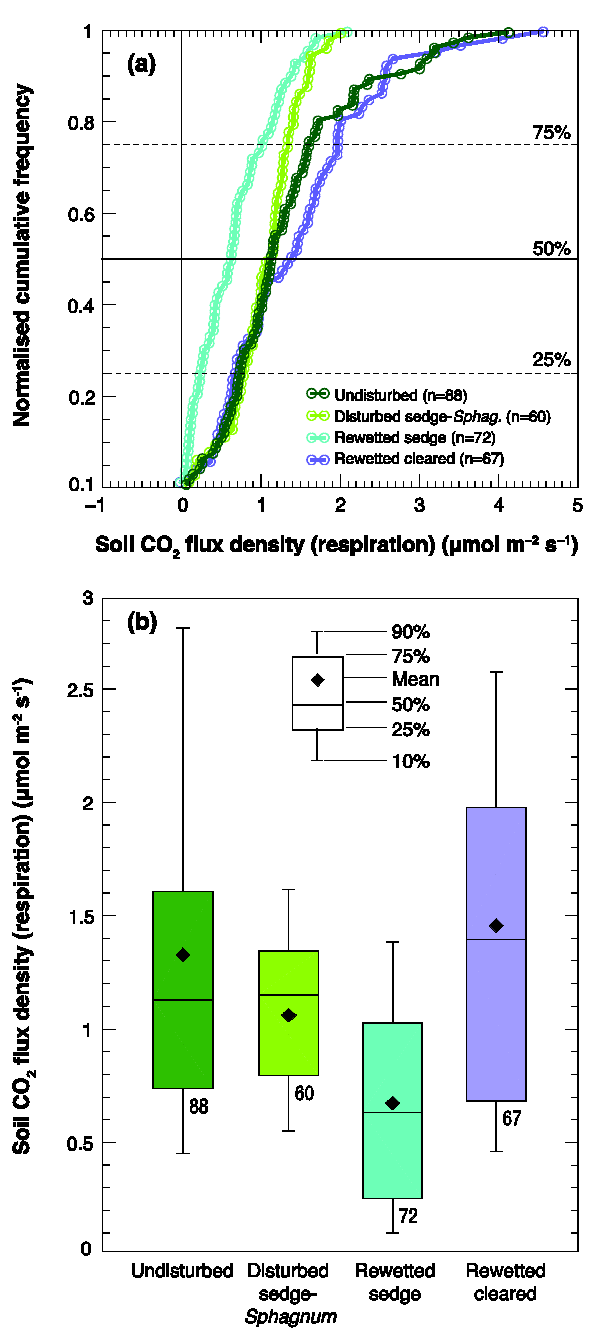
Figure 3. (a) Cumulative frequency distributions of all individual soil carbon dioxide (CO 2 ) flux measurements (µmol m -2 s -1 ) with an opaque chamber. Data from all sites and all collars represent soil respiration and autotrophic respiration of small plants within the collars, measured between 23 July and 07 August 2014; and (b) percentiles in the form of a boxplot. The number of measurements considered at each site is given in brackets (a) or below the boxes